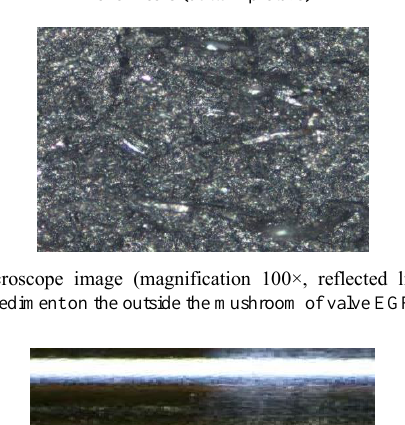
Fig. 3. Comparison of two pictures of EGR valve channels: channel with sediments (top picture), channel after partial removal of sediments with chemicals (bottom picture)